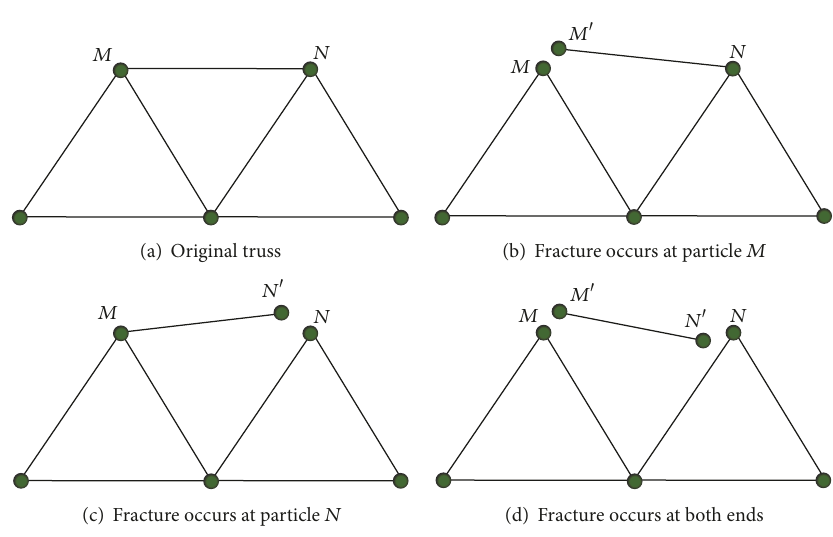
Figure 8: Failure modes of members of the